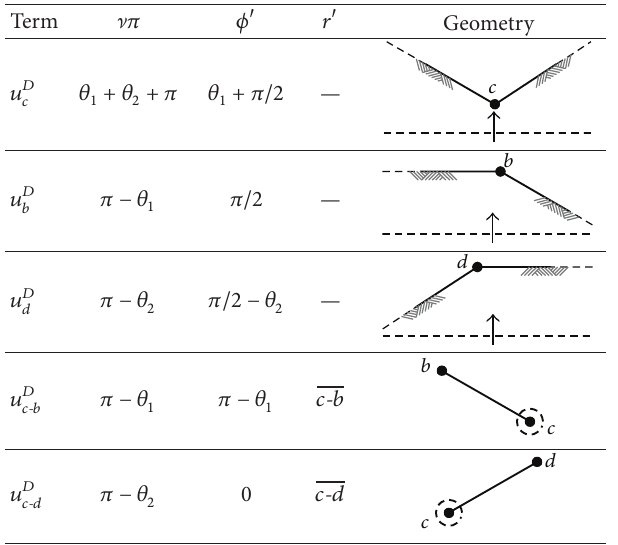
Table 1: Arguments for the evaluation of the diffraction terms appearing in (9) according to